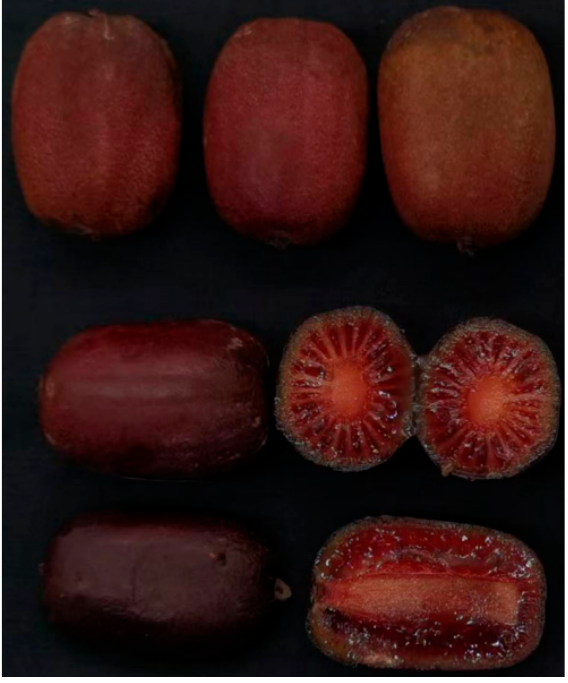
Figure 1. The fruit of kiwifruit cultivar A. arguta cv. Qinziyu.